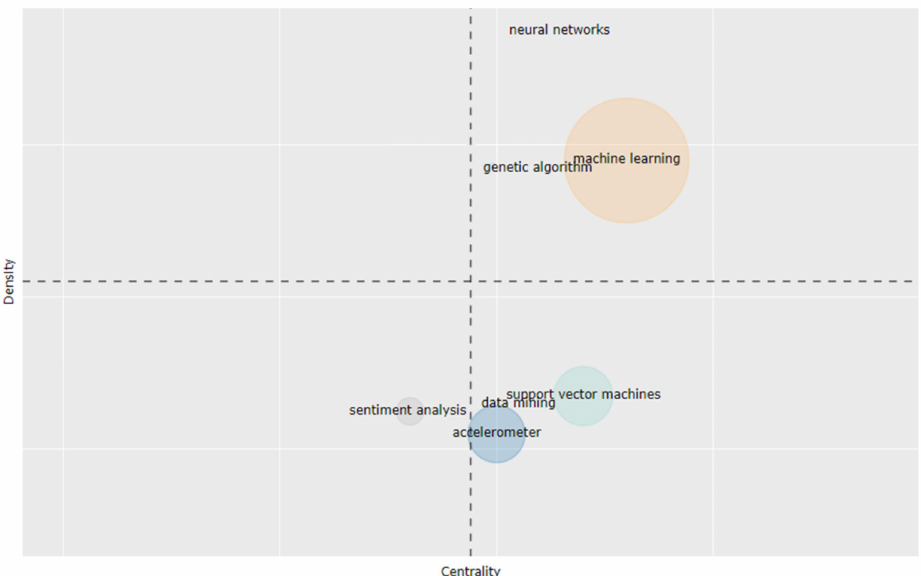
Figure 8. Thematic map, time slice